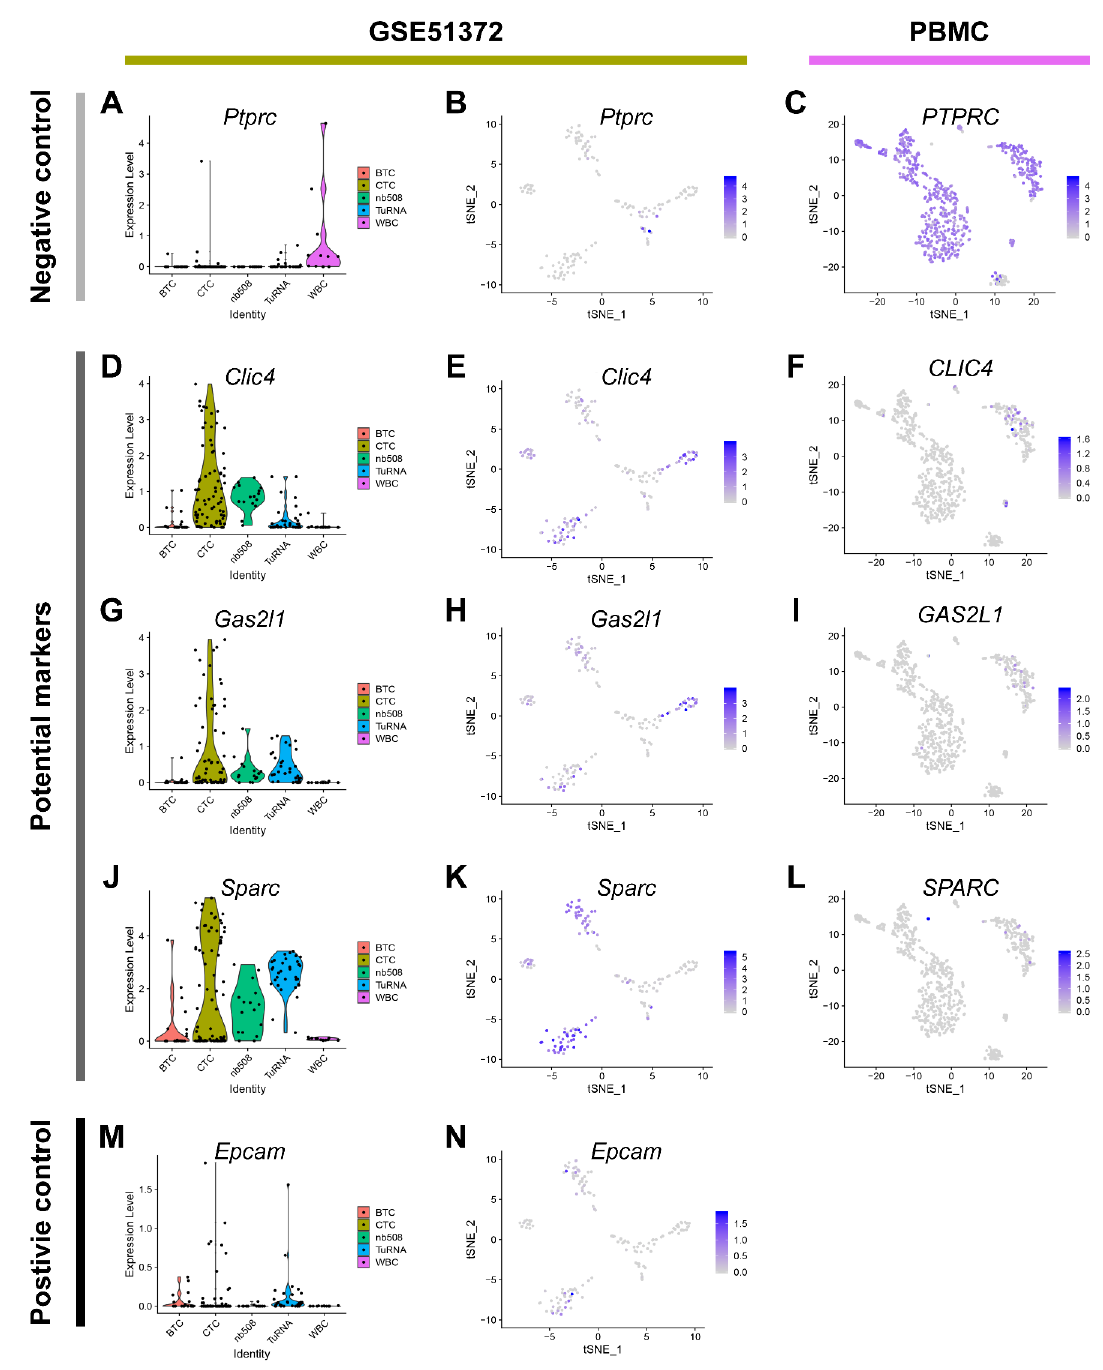
Figure 4. Expression of markers in circulating tumor cells (CTCs) and peripheral blood mononuclear cells (PBMCs). There are a violin plot and scatter plots for each marker to show the expression level in the CTC and PBMC datasets. Ptprc / Cd45 ( A – C ) is a negative control, Clic4 ( D – F ), Gas2l1 ( G – I ) and Sparc ( J – L ) are potential CTC markers, Epcam ( M , N ) is used as the positive control. Epcam is not expressed in the PBMC dataset. BTCs, bulk tumor cells; CTCs, circulating tumor cells; t-SNE, t-Distributed Stochastic Neighbor Embedding; TuRNA, RNA of the bulk tumor; WBC, white blood cells.